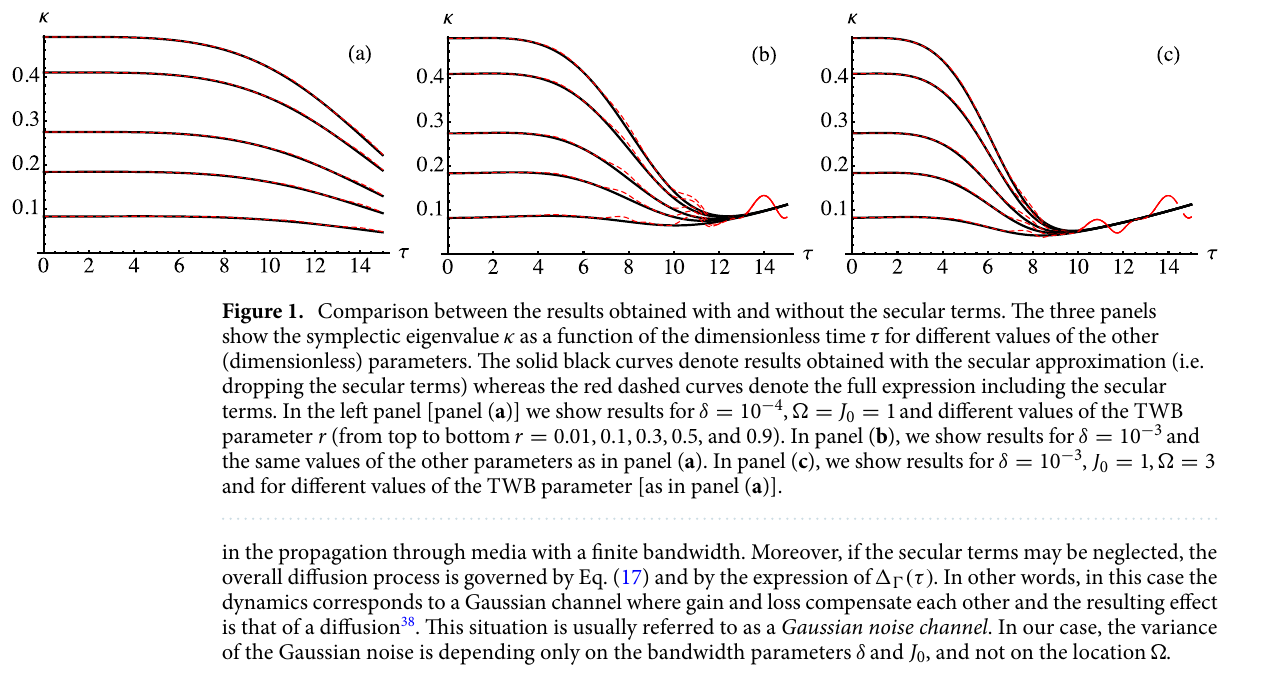
4 , (cid:31) 1 and different values of the TWB 10 J 0 − = = = 3 10 0.01, 0.1, 0.3, 0.5 , and 0.9). In panel ( b ), we show results for δ − = =